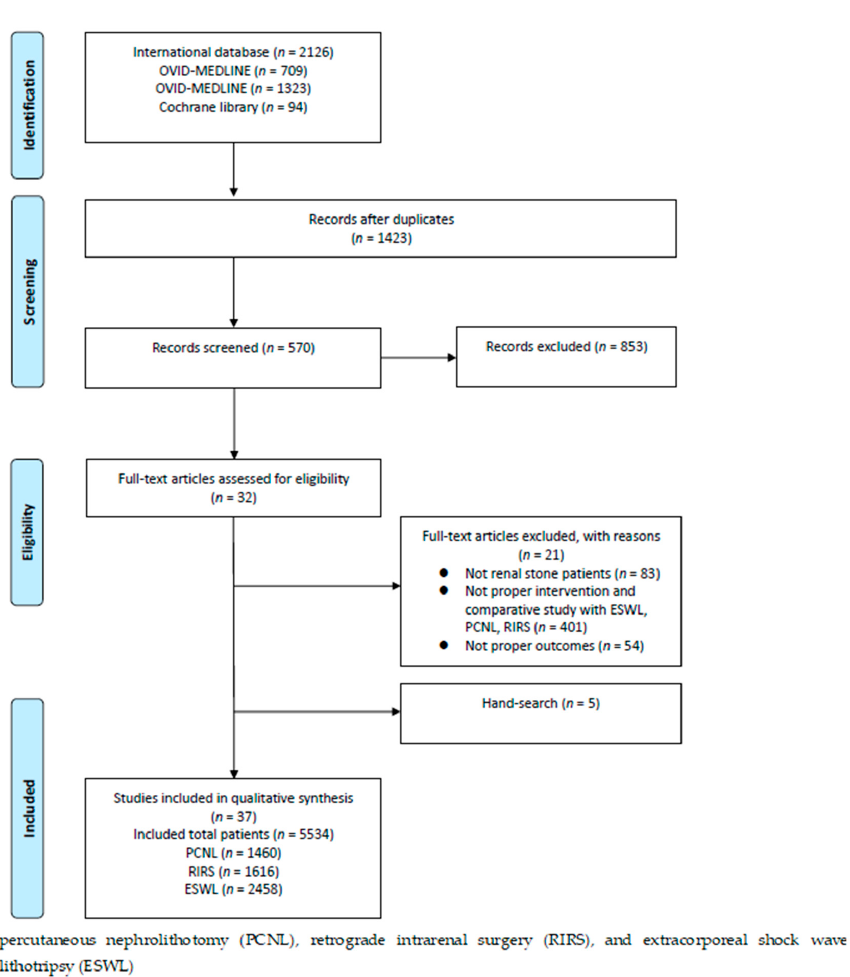
Figure 1. Study flow chart. Thirty-seven studies were included in the qualitative analysis.